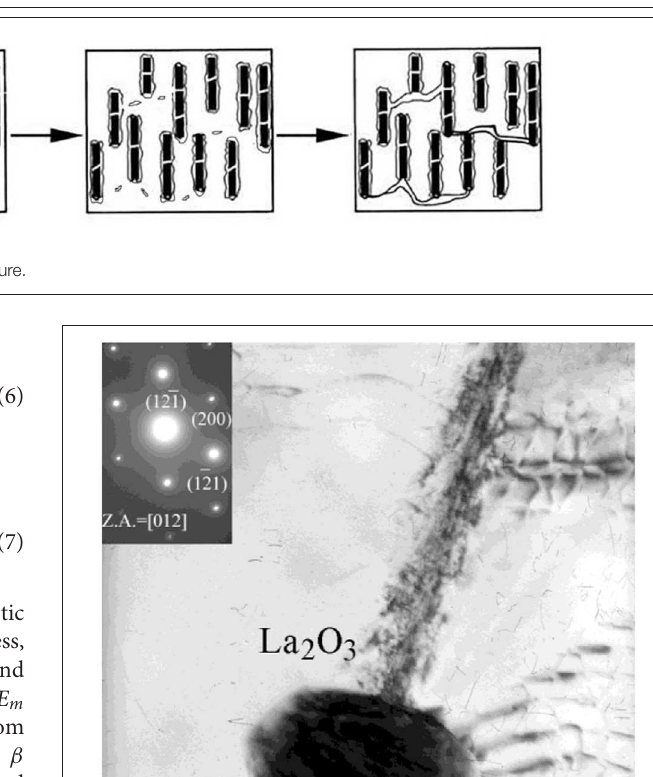
FIGURE 11 | SEM image of matrix alloy and TMCs near fracture surfaces after creep test. (A) Matrix alloy after HT1 at 923K, 200 MPa. (B) TMC after HT2 at 923K, 300 MPa.